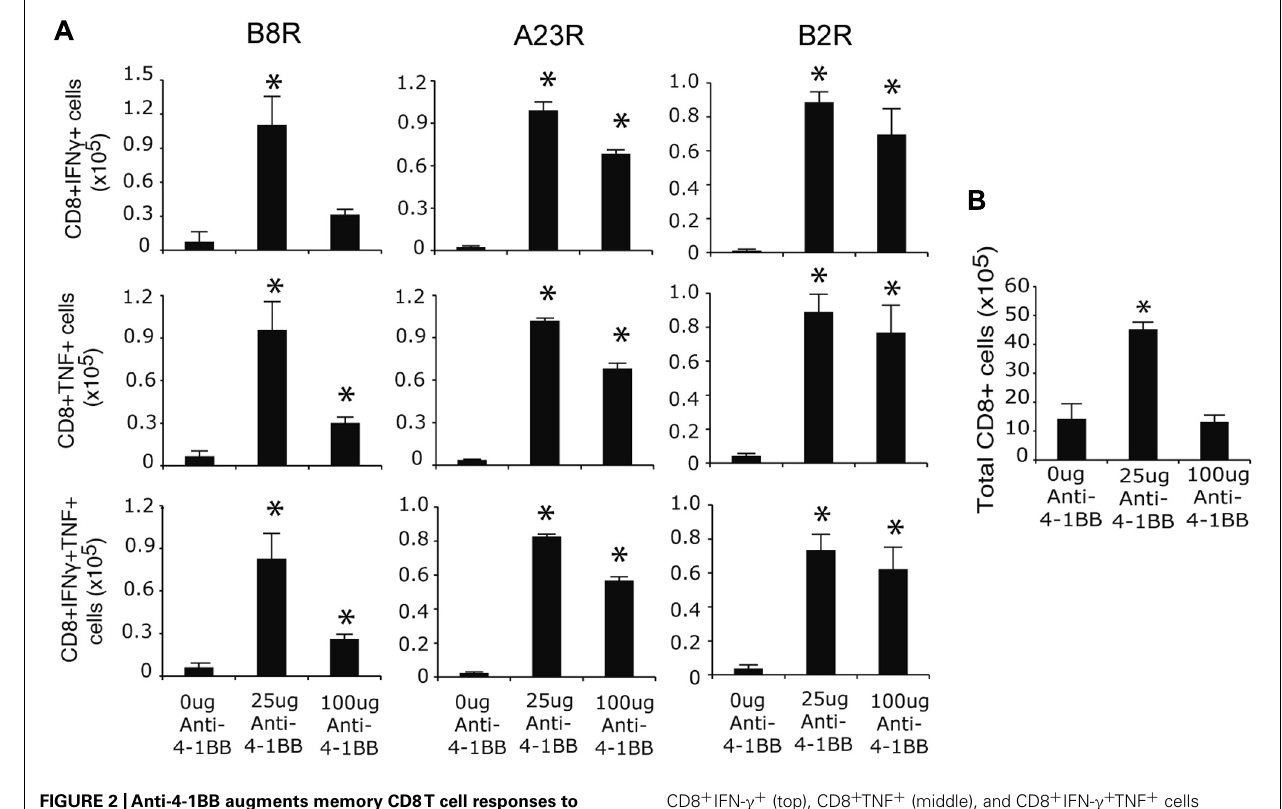
FIGURE 2 |Anti-4-1BB augments memory CD8T cell responses to VACV-WR. WT mice were infected i.p. withVACV-WR (2 × 10 4 PFU/mouse) and treated with 0, 25 or 100 μ g anti-4-1BB on day 1 post-infection.Thirty-five days after infection, (A) Splenocytes were stimulated with B8R, A23R, or B2R peptide, and stained for intracellular IFN- γ andTNF.Total numbers of